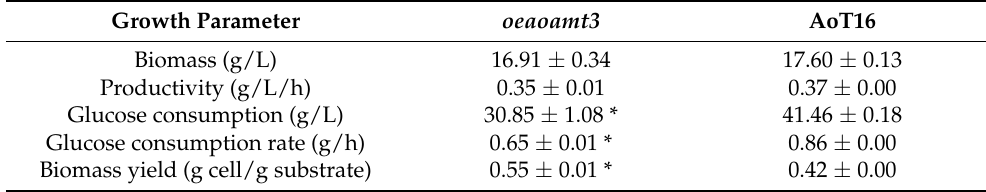
Table 1. Comparison of growth parameters between the overexpressed strain ( oeaoamt3 ) and the AoT16 recipient of A. oryzae .